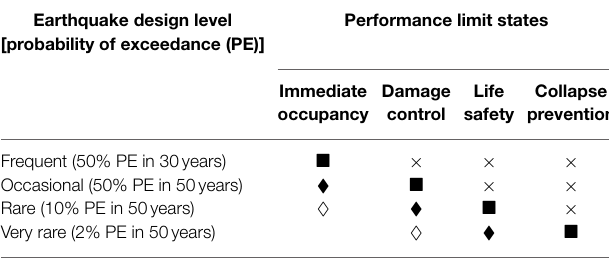
Frontiers in Built Environment |